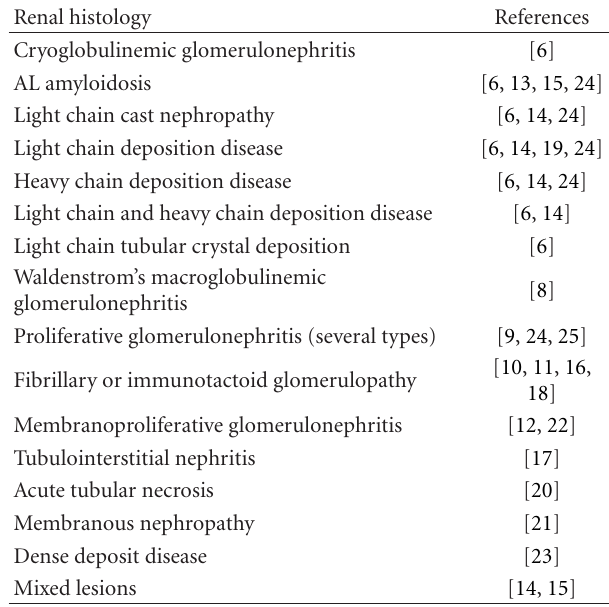
Table 1: Renal histological lesions during the course of